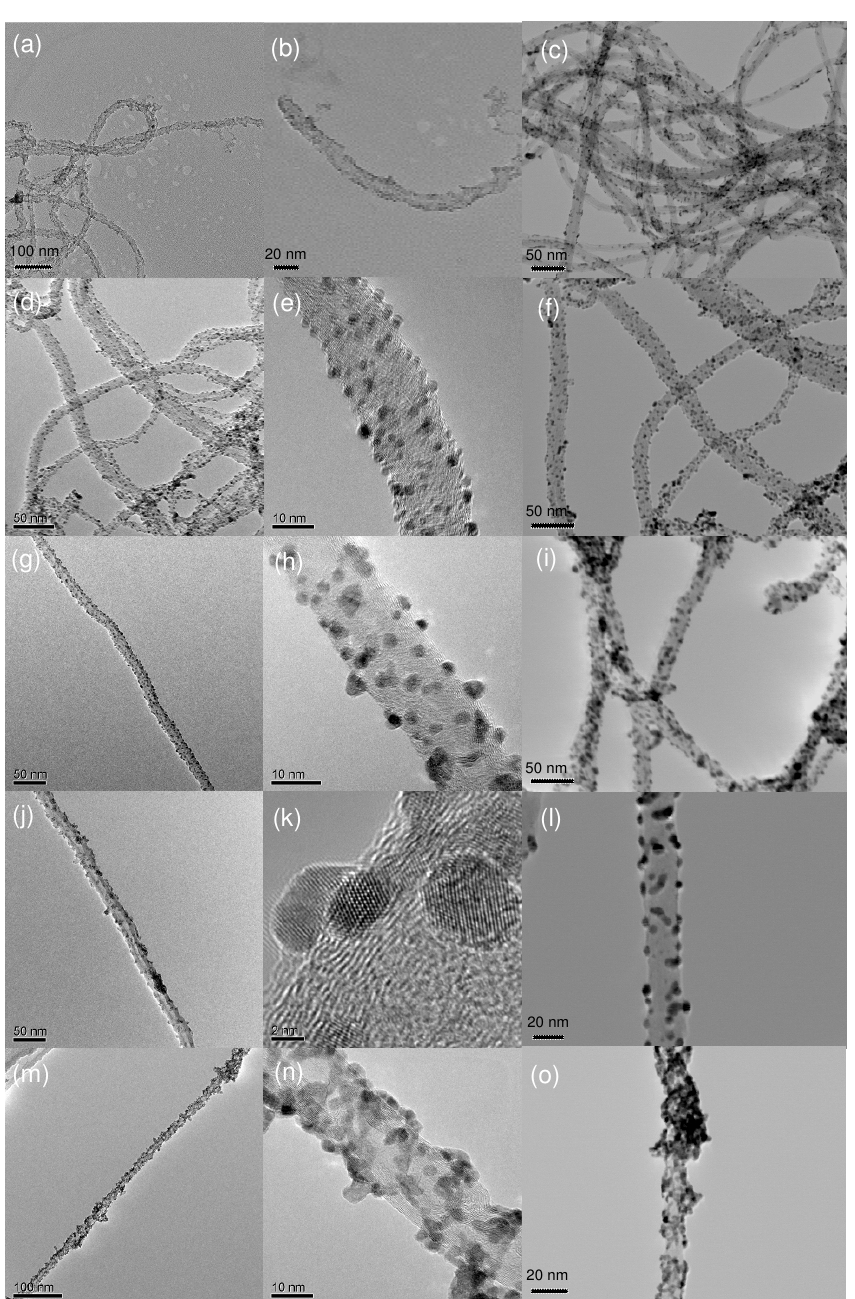
Figure 2. TEM and STEM images of pMWCNT/PdO (a-c), oMWCNT/PdO (d-l) of different reaction time (d-f: 1h, g-i: 10 h, and j-l: 20 h), and MWCNT- g -PAA/PdO (m-o). The left and middle columns represent the TEM images, and the right column the STEM